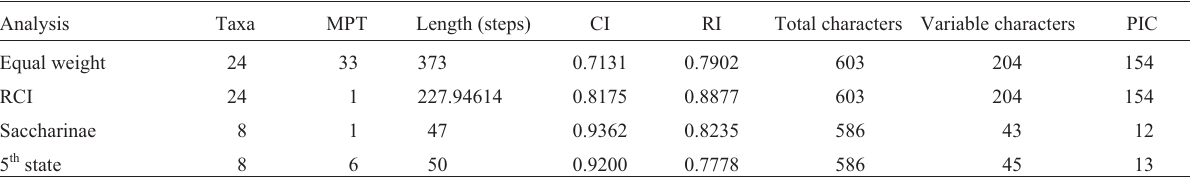
Table II - Parsimony analysis of the ITS1-5.8S-ITS2 region.